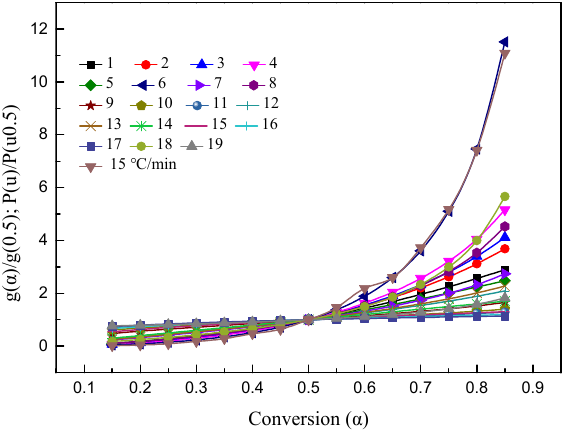
Figure 4. Comparison of experimental and theoretical curves based on Master Plot method.